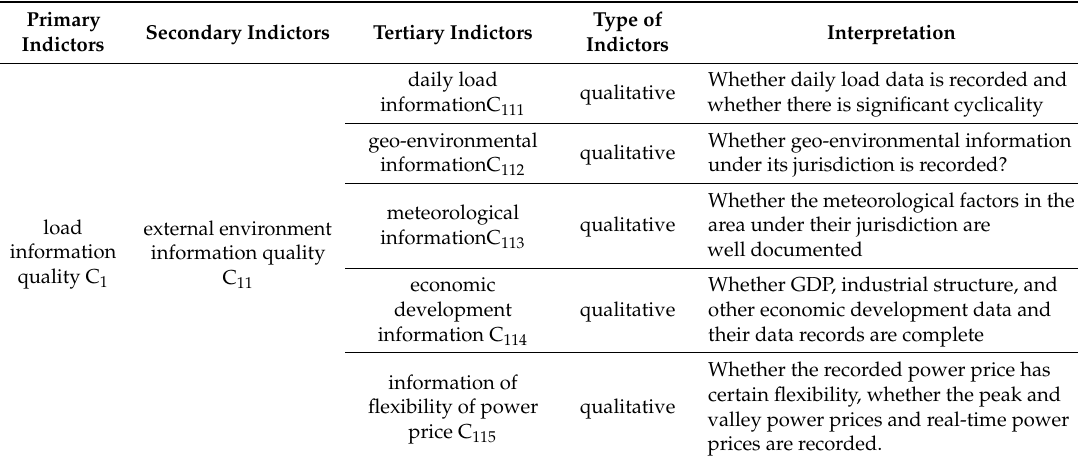
Table 4. Design table of evaluation index of DSM information